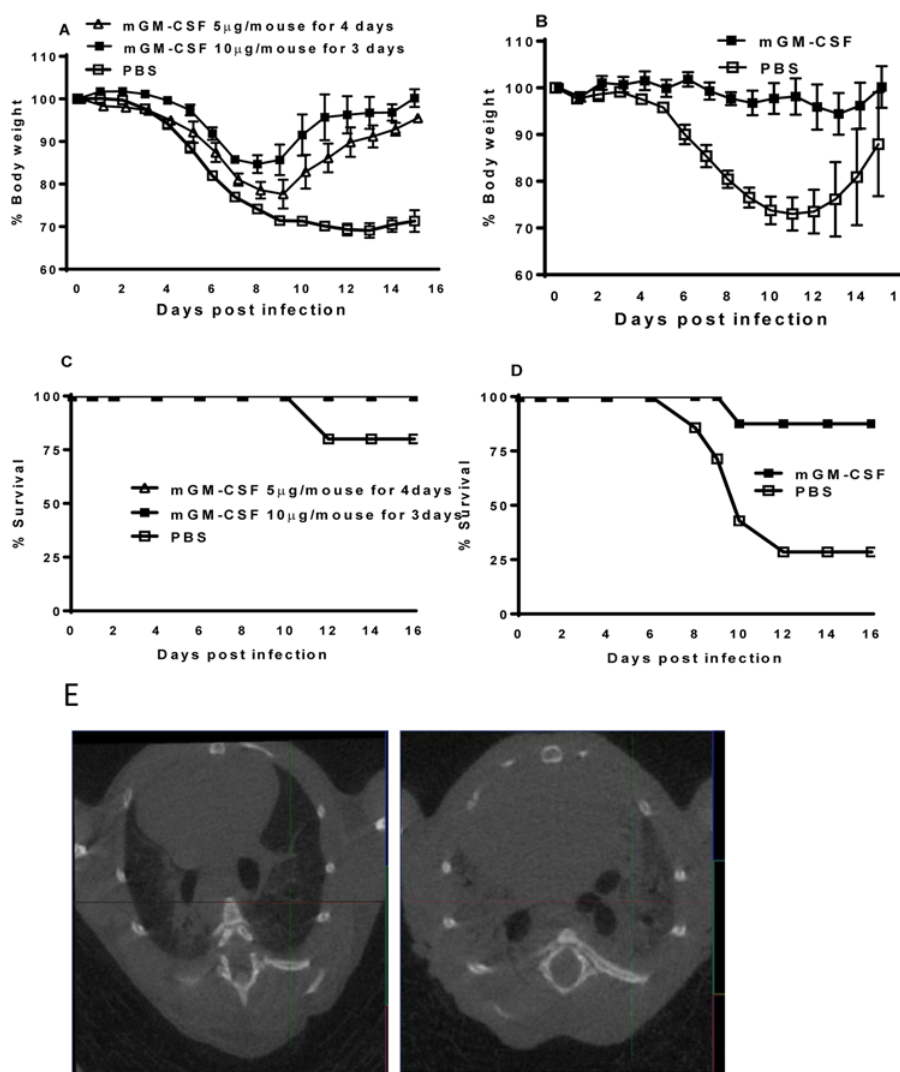
Fig 3. Effect of treating IAV-infected aged mice with GM-CSF. (A&C) Aged (20-months old) C57Bl/6 WT mice (5/group) were treated with PBS or two mGM-CSF regimens, and then infected with a sublethal dose (0.1 LD50) of IAV PR8, 24 hrs after the last treatment. (B&D) Aged C57Bl/6 mice were treated with 1.3 μ g mGM-CSF/g body weight (~26 μ g/mouse) or PBS daily for 1 week, and infected 24 hrs later with a lethal dose of PR8 (0.5 LD50). Weight loss and mortality were recorded daily. (E) Anatomical changes in the lungs of mGM-CSF-treated (E, left panel) and PBS-treated (E, right panel) aged mice after infection with IAV. Mice were treated and infected, as in panel B. Ten days post-infection, CT scanning was carried out, using a GE eXplore Locus micro CT scan. Transverse sections of the thorax are